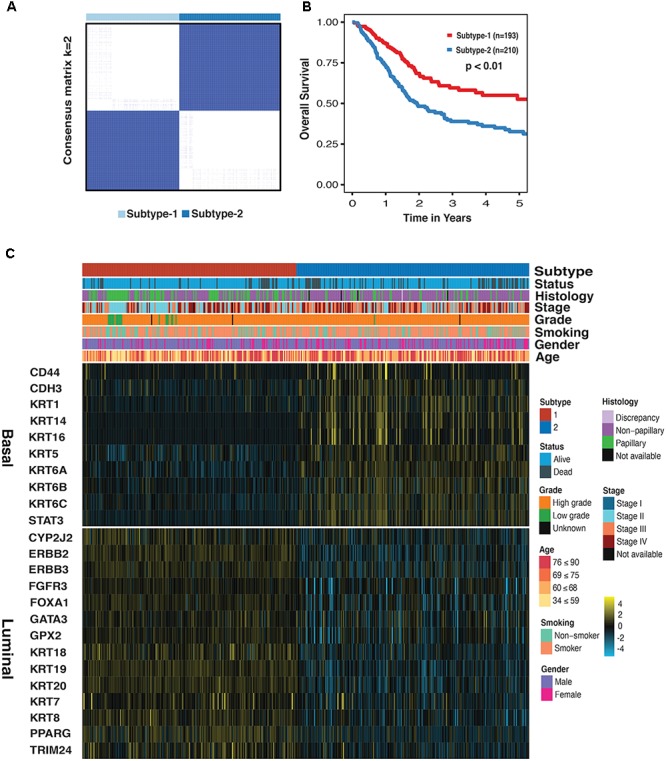
Subtype-1 and subtype-2 Classification for MIBC. (A) Hierarchically clustered heatmap for CoC dataset (K = 2). (B) A K-M plot for overall 5-year survival of subtype-1 and subtype-2 (subtype-1 = 193, subtype-2 = 210, p < 0.01). (C) Heatmap depicts the expression profiles of basal (up) and luminal (down) biomarkers in subtype-1 and subtype-2. Covariate annotation tracks show selected clinical features. The yellow and turquoise colors correspond to high and low relative expression, respectively.